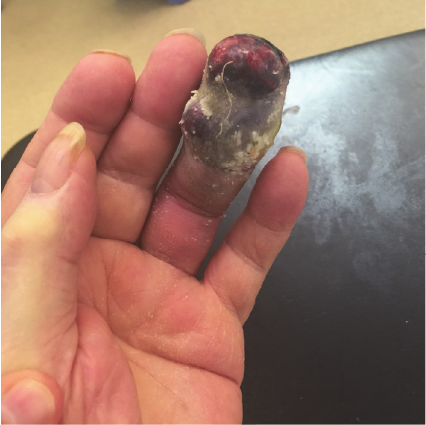
Figure 4: ADPA lesion after biopsy, palmar view.